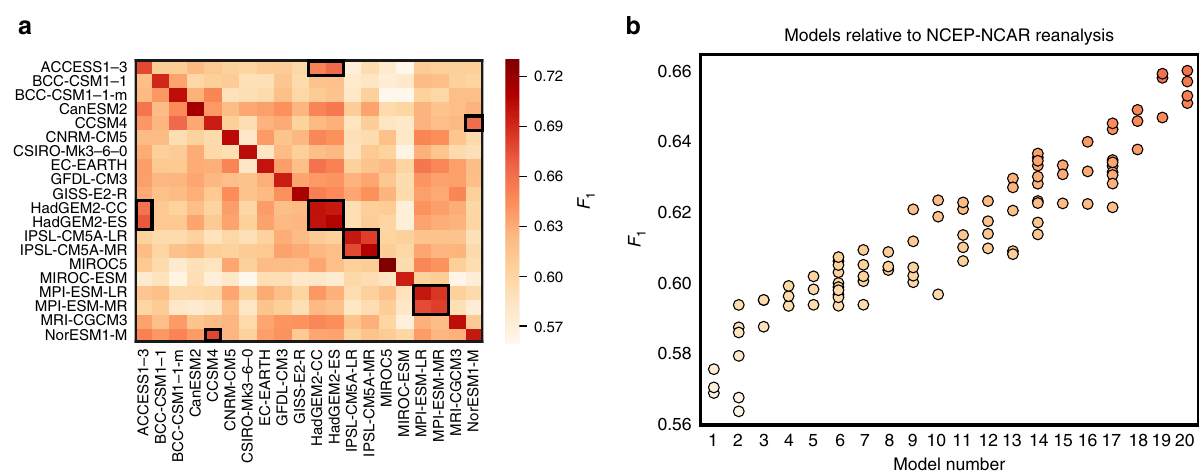
Fig. 3 Historical network comparisons. a As Fig. 2a, but for climate model simulations spanning approximately the historical period from 1st January 1948 to 31st December 2017 for which 20 CMIP5 models with up to ten different ensemble members are available. b Ordered F 1 -scores when the causal fi ngerprint learned from NCEP-NCAR reanalysis data is taken as the reference. Differences in b are highly statistically signi fi cant, with p -values < 9 × 10 – 10 for a non-parametric Kruskal – Wallis-test and p < 5 × 10 – 30 for a standard one-way ANOVA F -test. The model key for b is provided in Supplementary Table 1. We note that similar model rankings have been found regionally for precipitation, e.g., for China 55 . Individual network scores (marker colours) in b follow the colour code from ( a ). Source data are provided as a Source Data fi